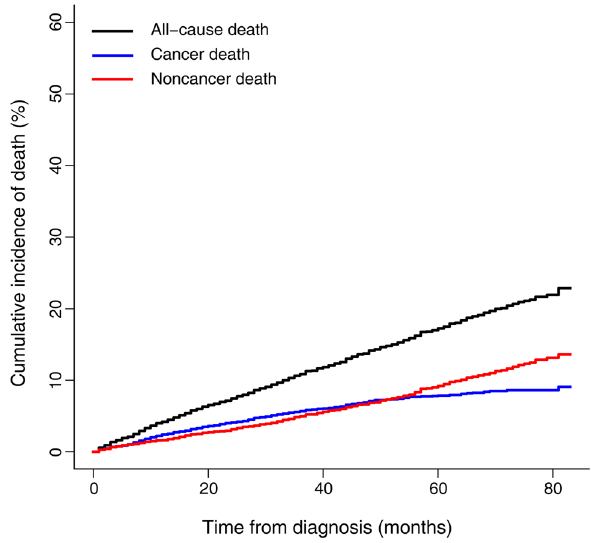
Figure 2. Cumulative incidences curves of cancer and noncancer death in the total cohort. The figure was performed using R software (version 4.0.3, R Core Team 2020, https:// www.r- proje ct.